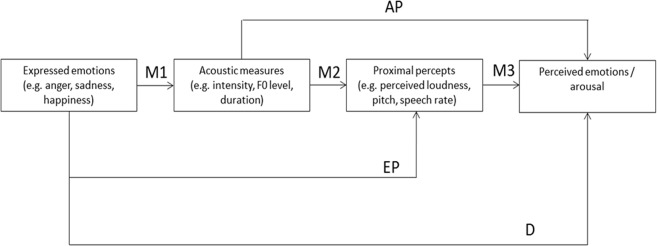
Conceptual representation of the TEEP path model.